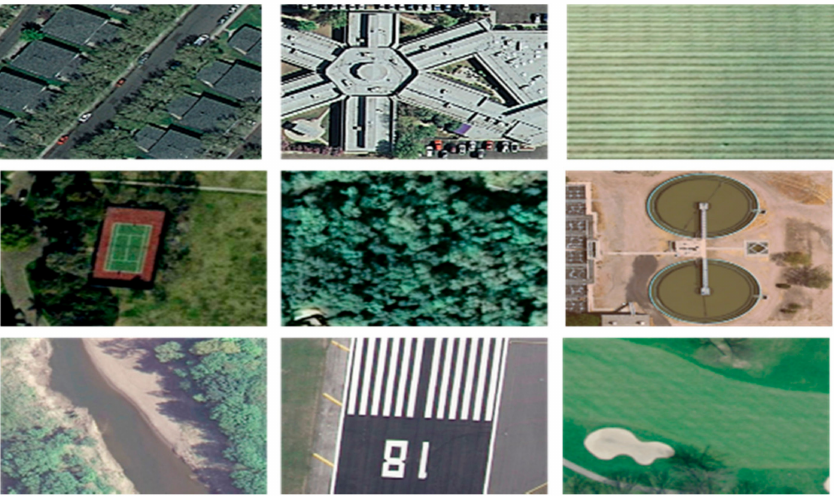
Figure 12. A few classes of the UCM